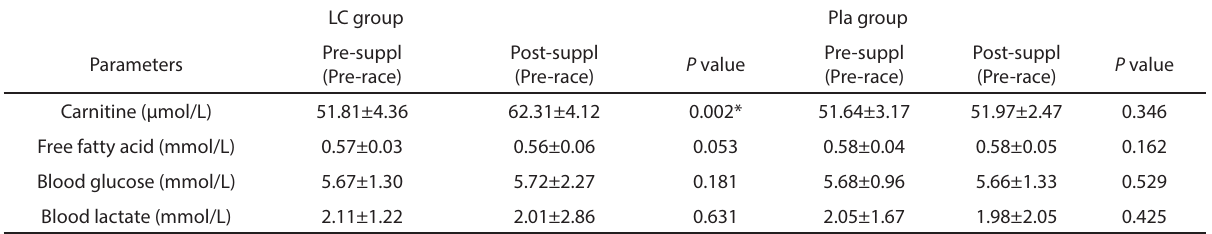
Table 2. Physiological parameters before start of the race within a group before and after supplementation period